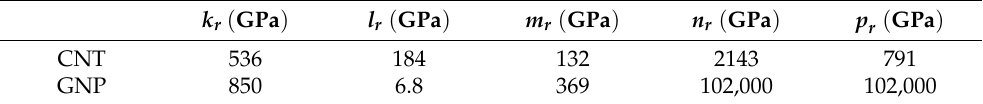
Table 1. Mechanical properties of nanofillers in form of Hill’s elastic moduli.